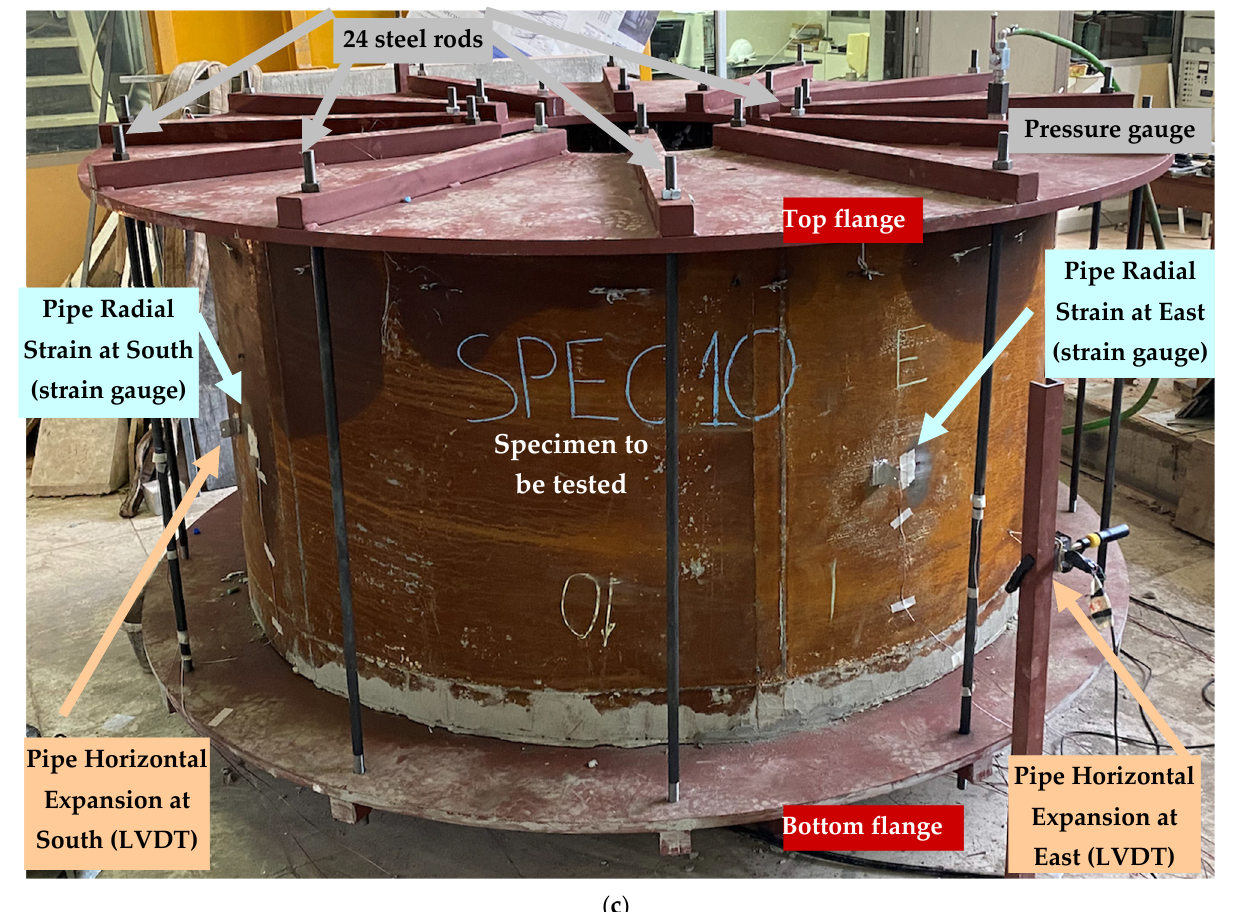
Figure 13. ( a ) A cross ‐ section of the loading arrangement perpendicular to the longitudinal axis of the pipe showing: (1) the 260 mm thick reaction cylinder in the interior (red colour) with internal and external radii of 580 mm and 840 mm, respectively. (2) The pipe specimens at the exterior (grey colour) with a thickness ranging from 100 mm to 200 mm. The gap in between (white colour) is filled with water under pressure. The indicated external diameter of 1080 mm represents the maximum possible value of the pipe diameter when reinforced with the external RC jacket. ( b ) A cross ‐ section c ‐ c of the loading arrangement of ( a ). ( c ) Experimental set ‐ up for testing the PCCP pipe specimens under an internal hydraulic pressure loading arrangement.